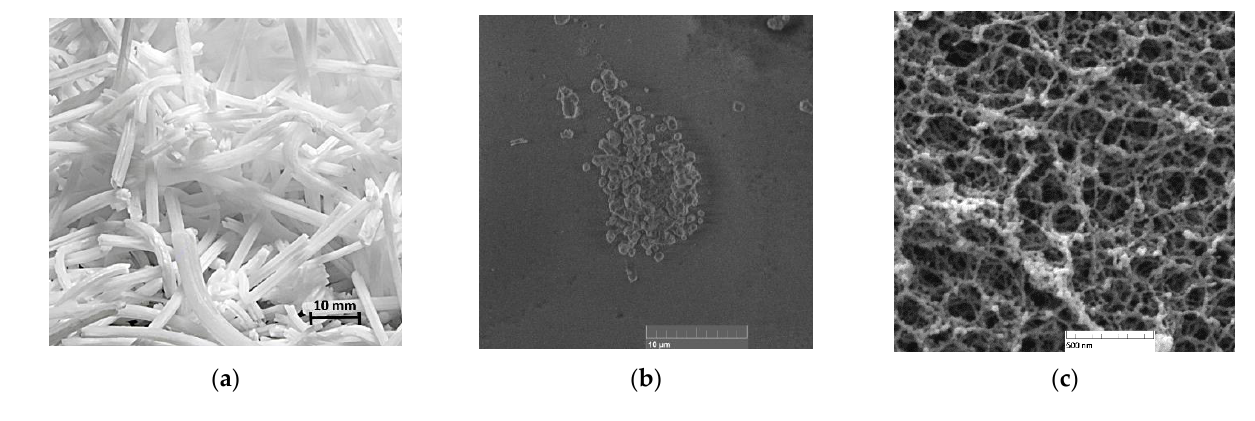
Figure 8. Photo of boron oxide wires ( a ) and SEM image of BLC ( b ) and silica aerogel ( c ).